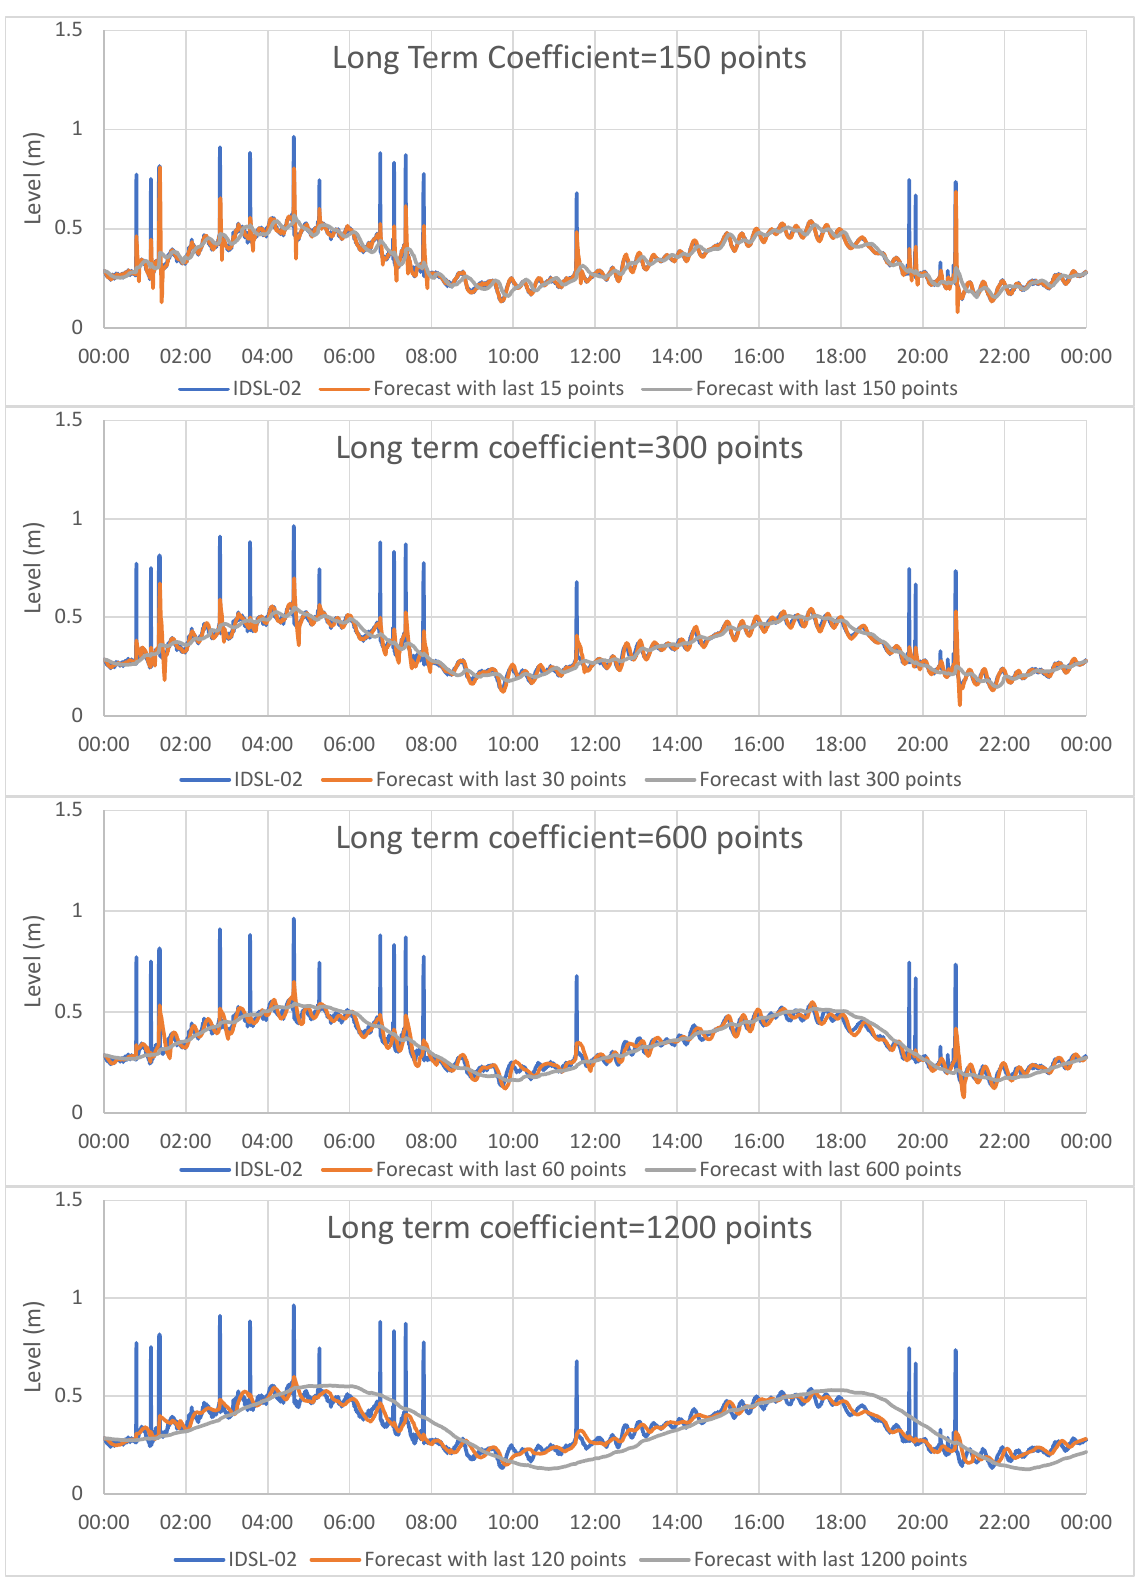
Figure 7. Estimation of parameters for the Saidia Marina signal.